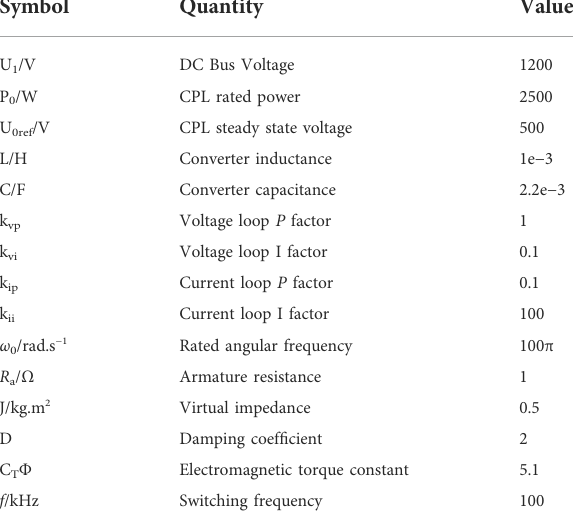
TABLE 1 DC microgrid system